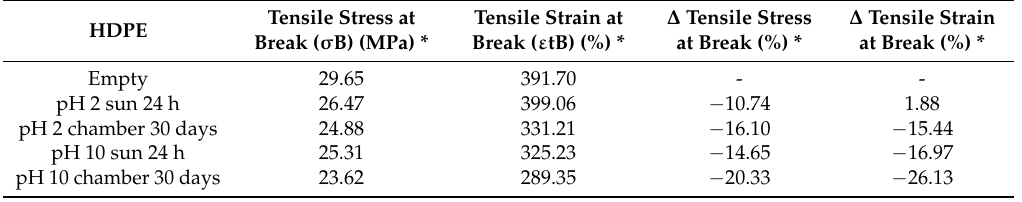
Table 3. Results obtained by mechanical analyses for HDPE containers.